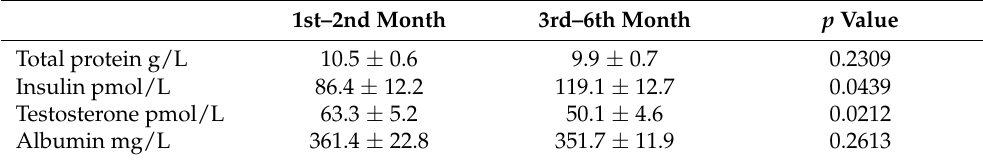
Table 1. Total protein, insulin, testosterone, and albumin in preterm ( n = 114) breast milk samples.